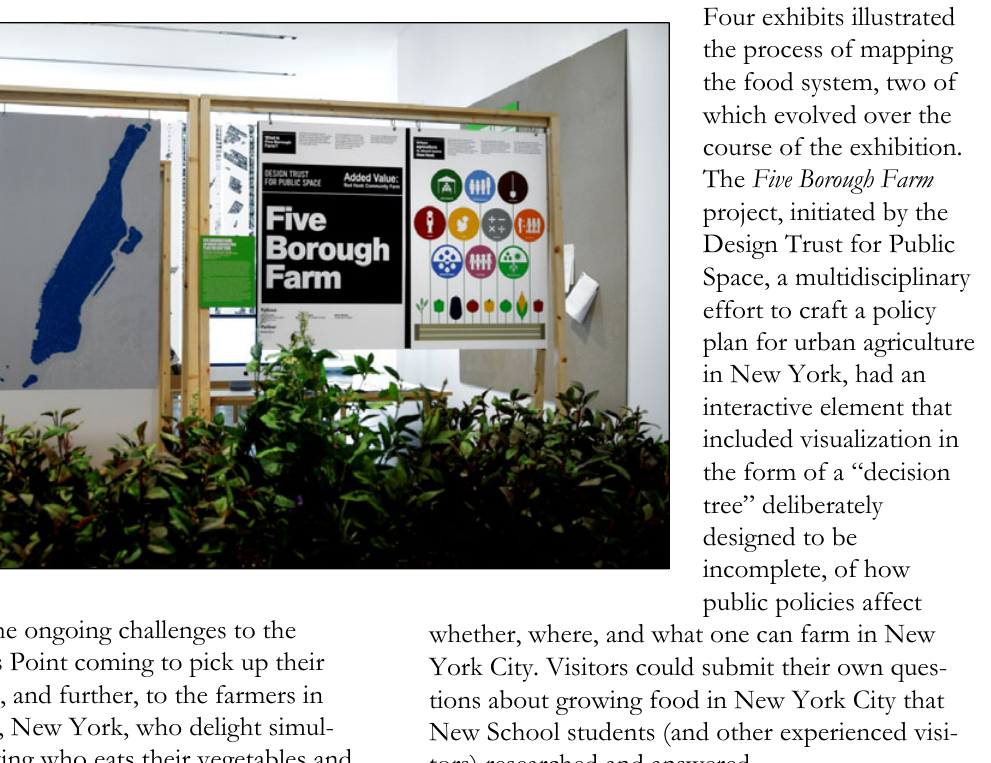
Figure 5. Five Borough Farm